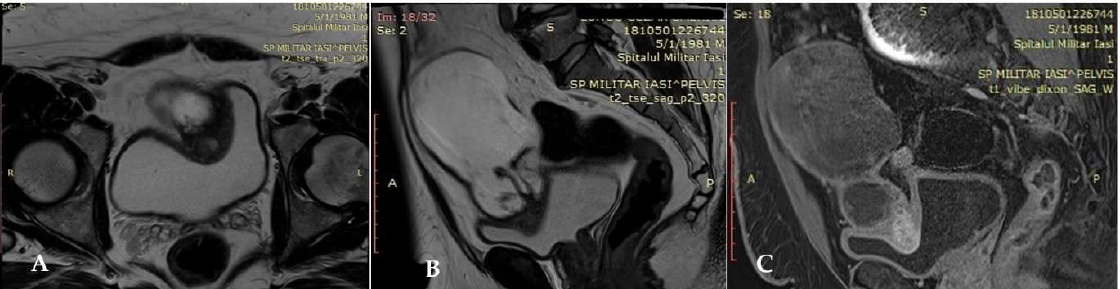
Figure 2. ( A – C ) Cystic lesion extended from umbilicus to antero-superior dome of the bladder, on the trajectory of the medial umbilical ligament ( A , B ) and with involvement of the antero superior bladder wall ( C ).